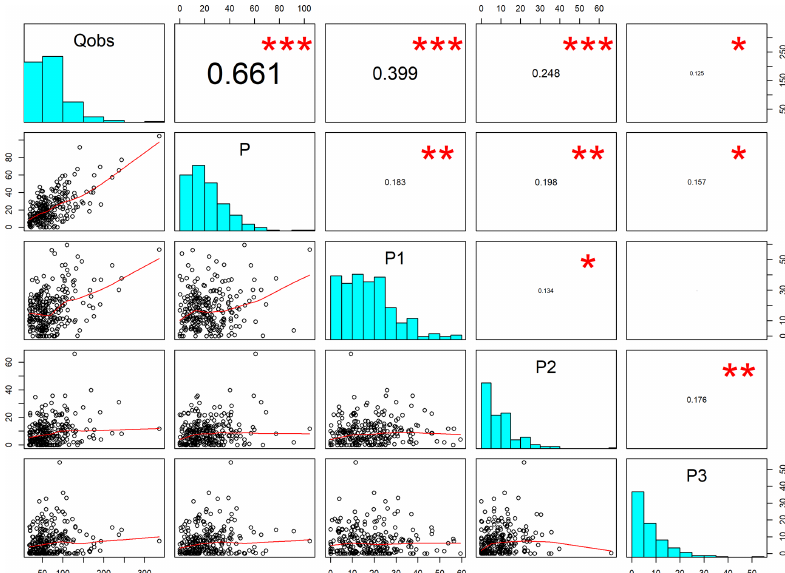
Figure 3. Diagram representing the process used to establish the critical duration for Krinsvatn. The stars represent the degree of significant correlation between Q obs and P on the day of the peak and − 1, − 2 and − 3 days before the peak at p = 0 . 01. The critical duration is set in this case to 2 days because the correlation between Q obs and P and P 1 is greater than